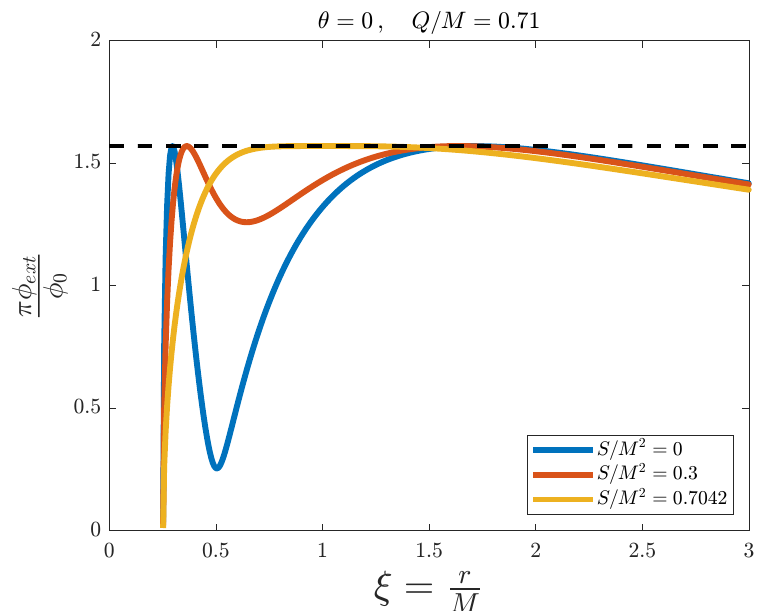
Figure 9. External magnetic flux πφ ext / φ 0 versus the adimensional distance ξ = r / M for the simulation of a Kerr–Newman black hole with fixed θ = 0 and A = Q / M = 0.71, and for different values of B = S / M 2 . The dashed line represents the threshold value πφ ext / φ 0 = π